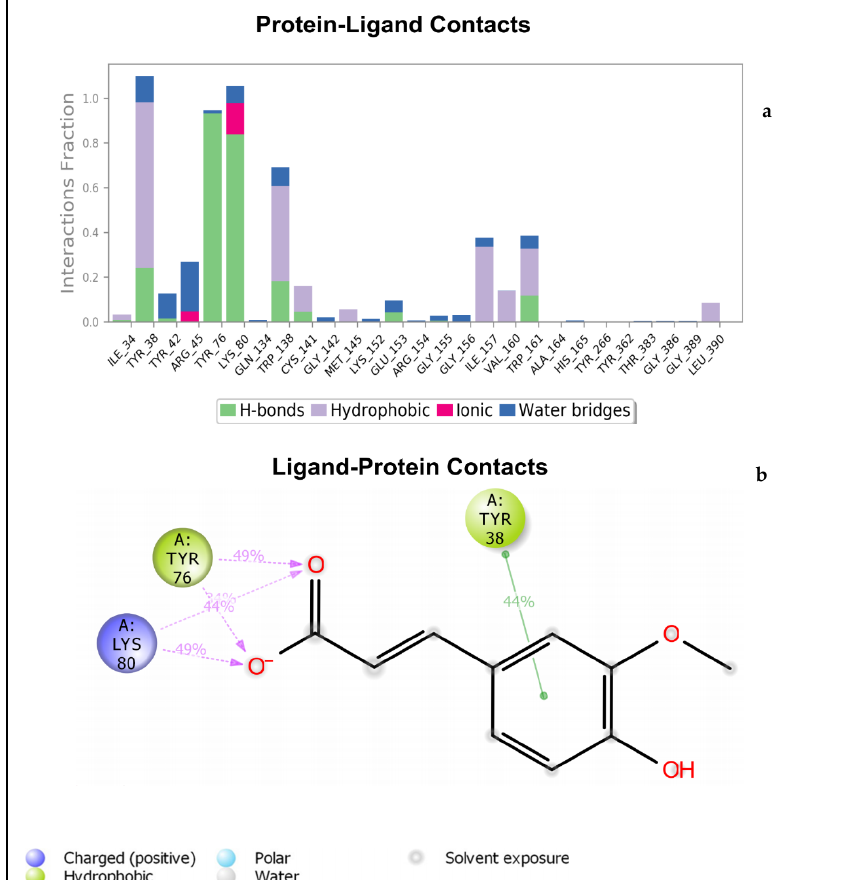
Figure 4. ( a ) Bar chart plot detailing protein-ligand interactions of sinapic acid-NorA complex with the key amino acid residues at NorA active site. ( b ) Simulation interaction diagram detailing the interaction of sinapic acid with NorA that occur in 30% of simulation time from 0–100 ns.